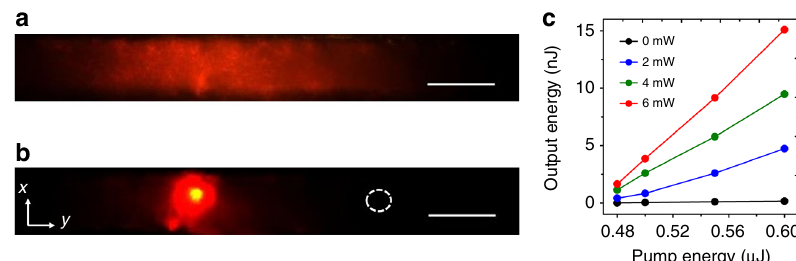
Fig. 3 Directional random lasing. Random lasing observed at the output facet of the sample, in the plane xy , for pump pulses above threshold, E = 0.55 μ J. a Emitted light without a co-launched nematicon; b emitted light in the presence of 6 mW nematicon (the near-infrared was fi ltered out). The white dashed circle indicates the position of the input beam, launched with wave-vector parallel to z . The lateral displacement of the random laser spot is due to soliton walk-off in the plane yz . The scale bars refer to a length of 100 μ m. c Output random laser energy versus pump energy/pulse above threshold for various near-infrared nematicon powers. The measured values are averaged over 200 samples and corrected for Fresnel re fl ection losses due to fi lters, lens,